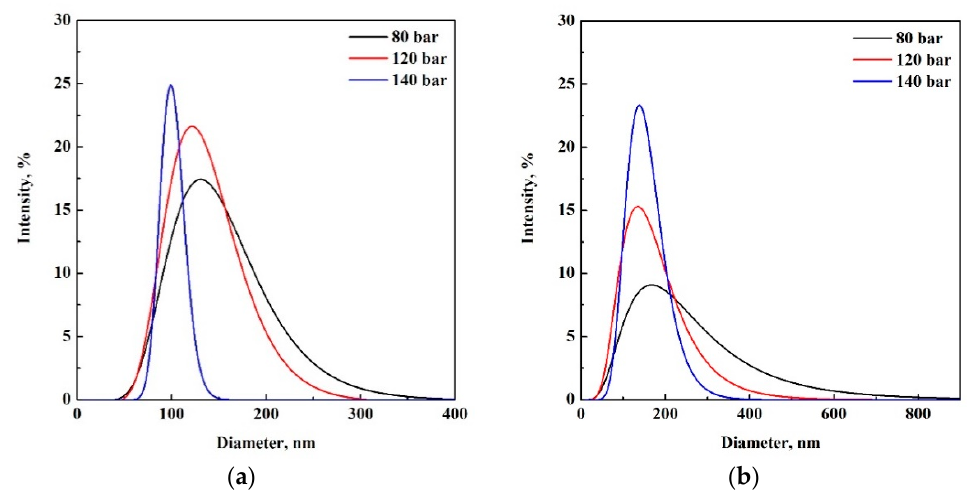
Figure 3. PSDs of samples produced by SC-CO 2 assisted electrospray at P = 80 bar (black), P = 120 bar (red) and P = 140 bar (blue); V = 30 kV and PLGA concentrations: ( a ) 1% w / w and ( b ) 3% w / w .